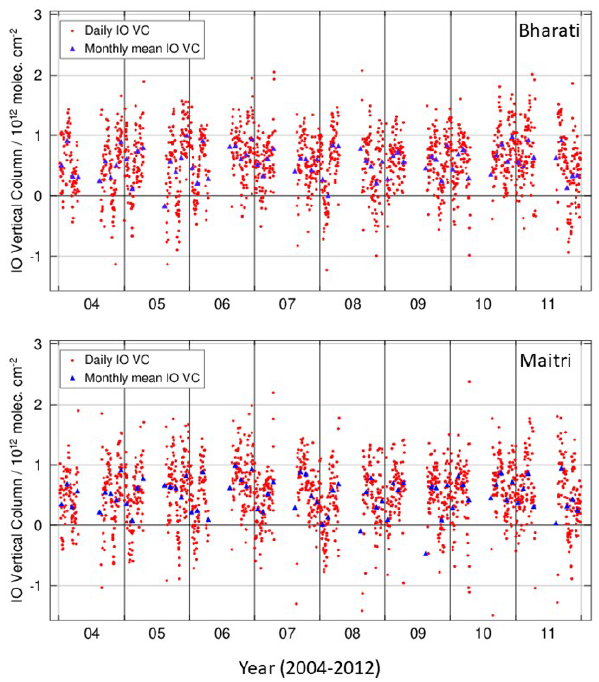
Figure 10. Time series of IO VCD observations at Bharati station retrieved by SCIAMACHY. The monthly mean values are shown in blue, and the daily data points are shown in